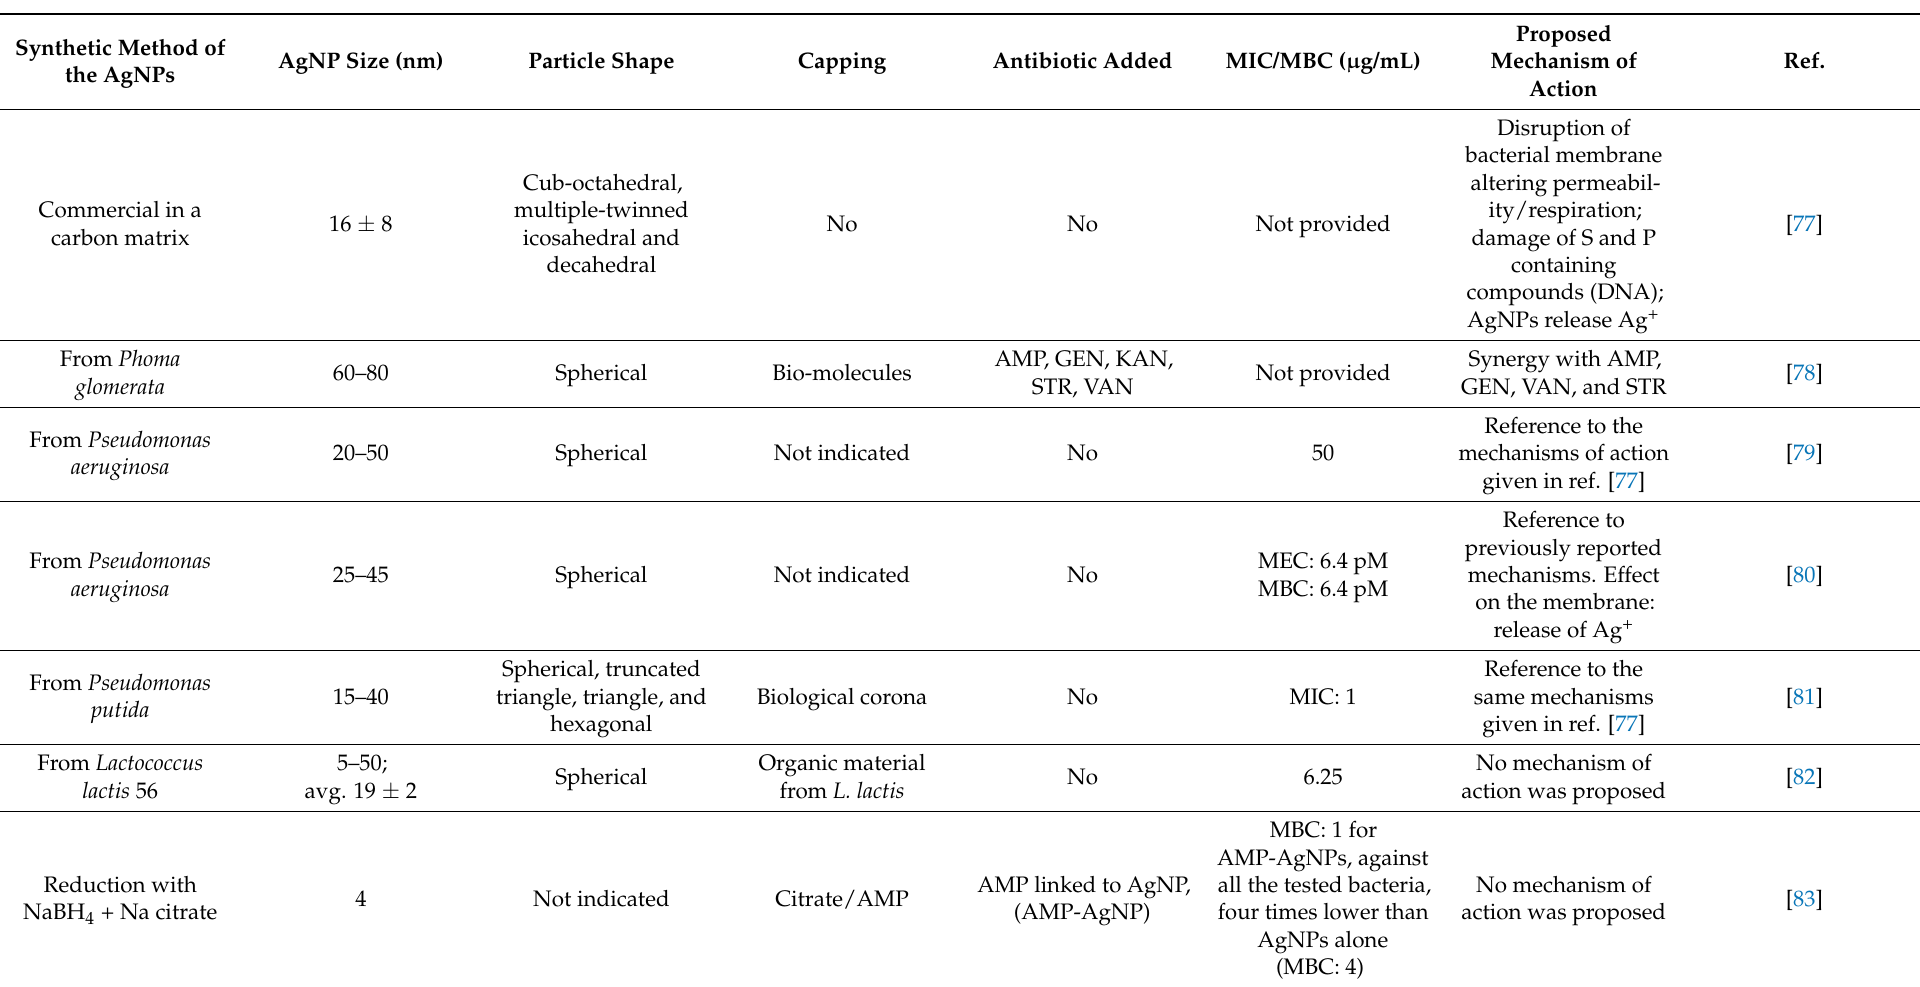
Table 2. Research on the activity of AgNPs against Pseudomonas aeruginosa in vitro